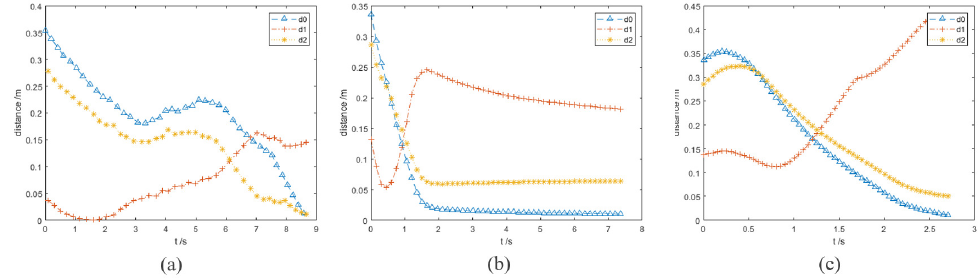
Figure 7. Experiments B: the running process of the robot arm when it is using three different algorithms. ( a ) informed RRT*; ( b ) VPF; ( c ) IVPF.